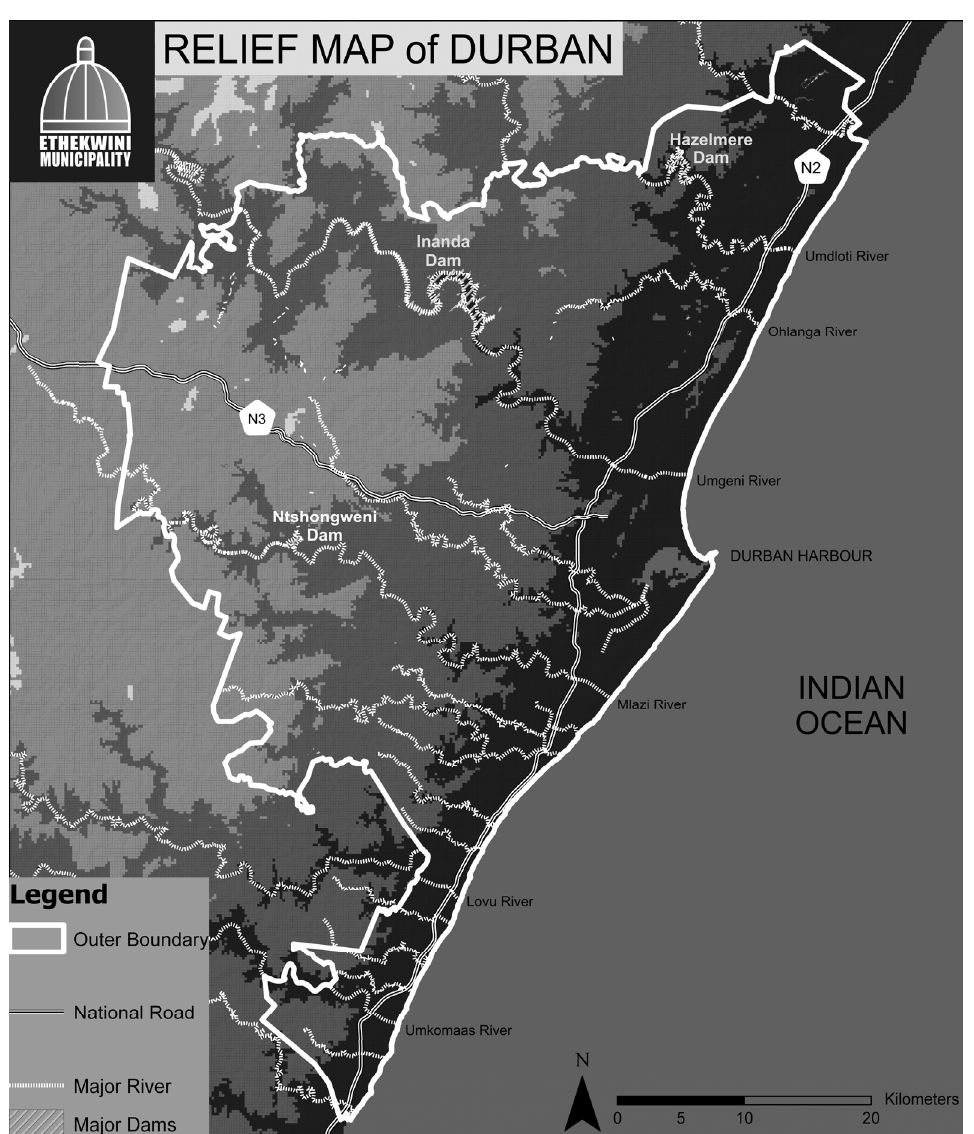
Figure 3. Map showing the eThekwini municipal